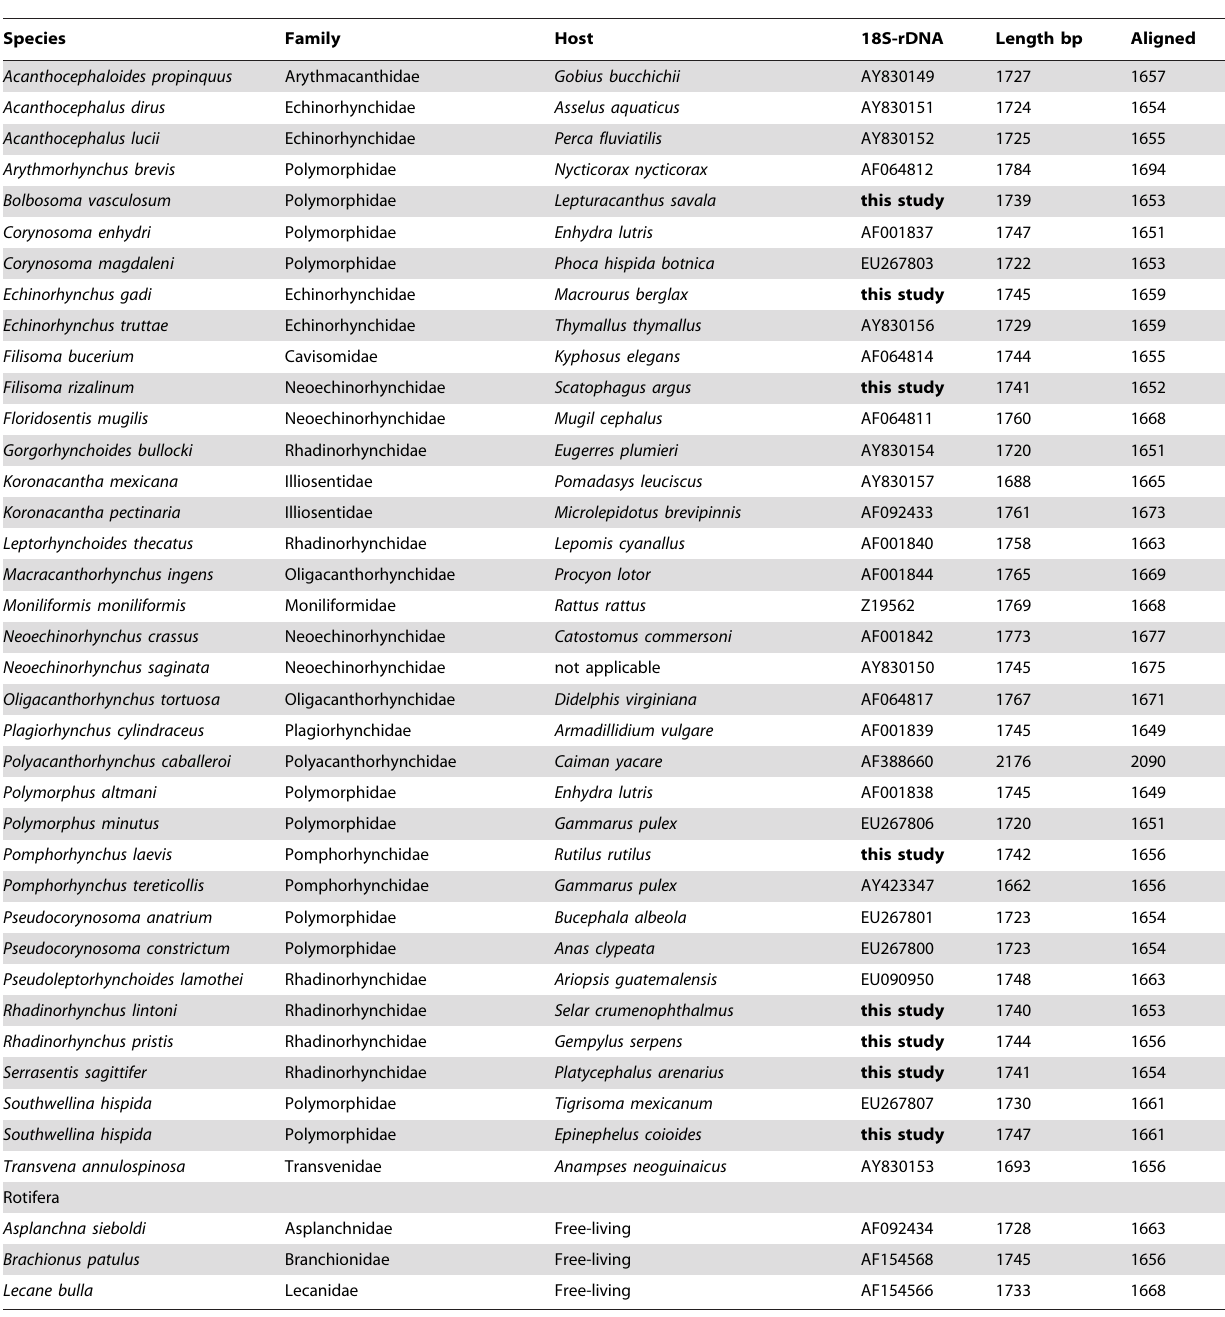
Table 2. Acanthocephala and Rotifera specimen information and GenBank accession numbers.